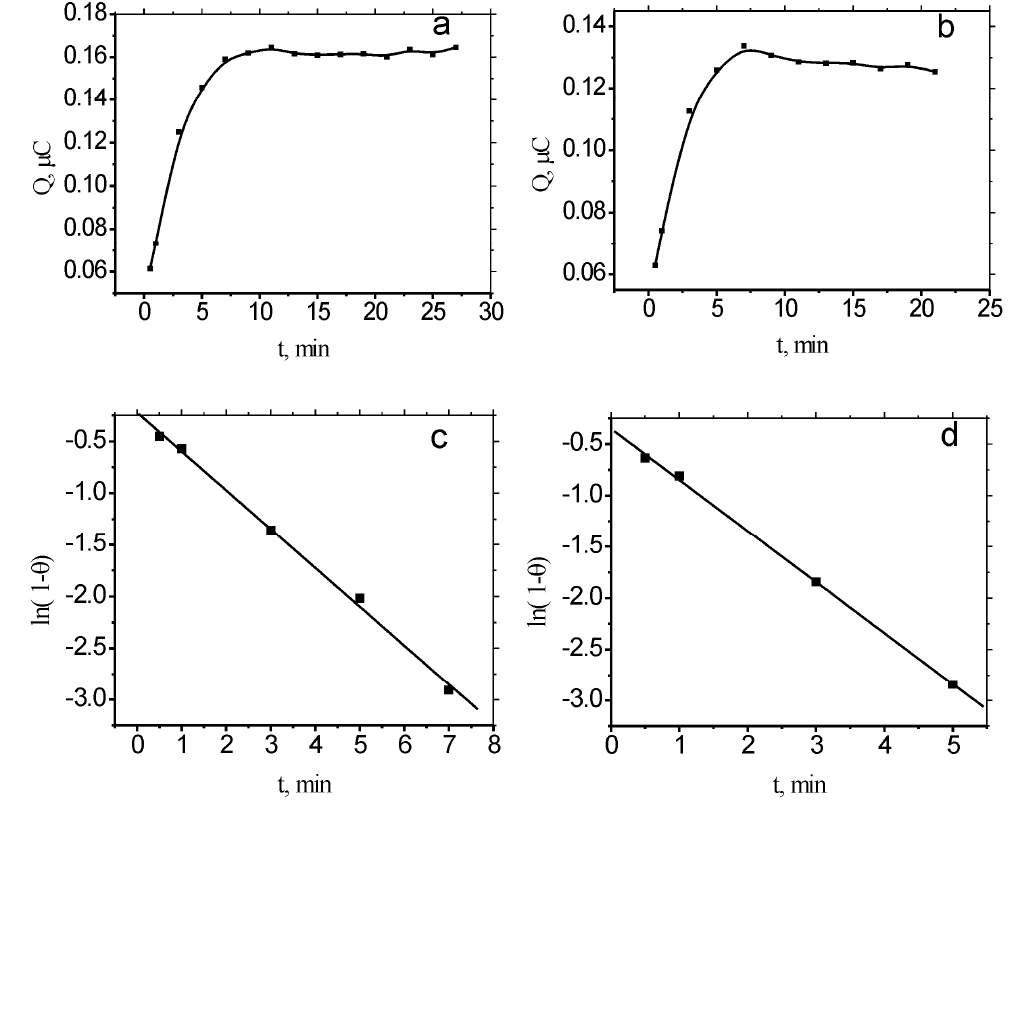
Figure 4. Integrated charge of cathodic peaks from CVs of 3 μ M MB on ds-DNA/Au (a) and ss- DNA/Au (b) at 50 mV/s as function of the incubation time. Plot of ln (1- θ ) versus incubation